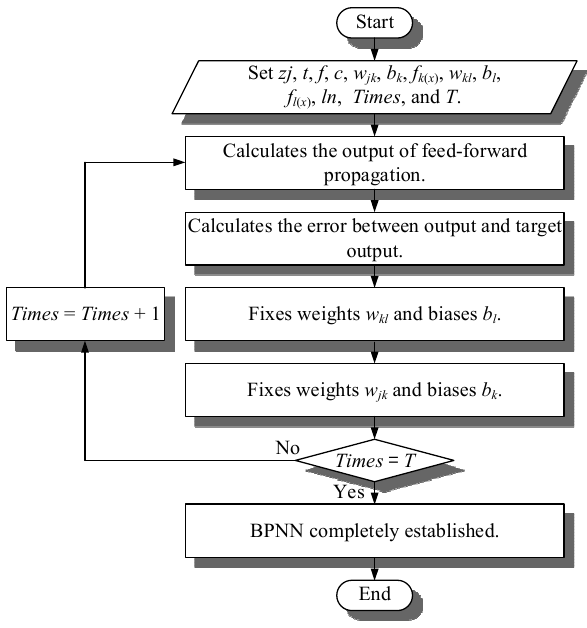
Figure 6. Flowchart of the ANN.